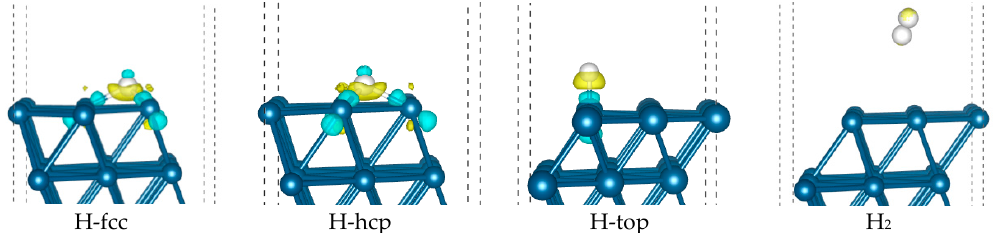
Figure 2. Charge density difference (CDD) of H(a) and H 2 on Pt(111). The isosurface value is 0.005 e/a 03 .